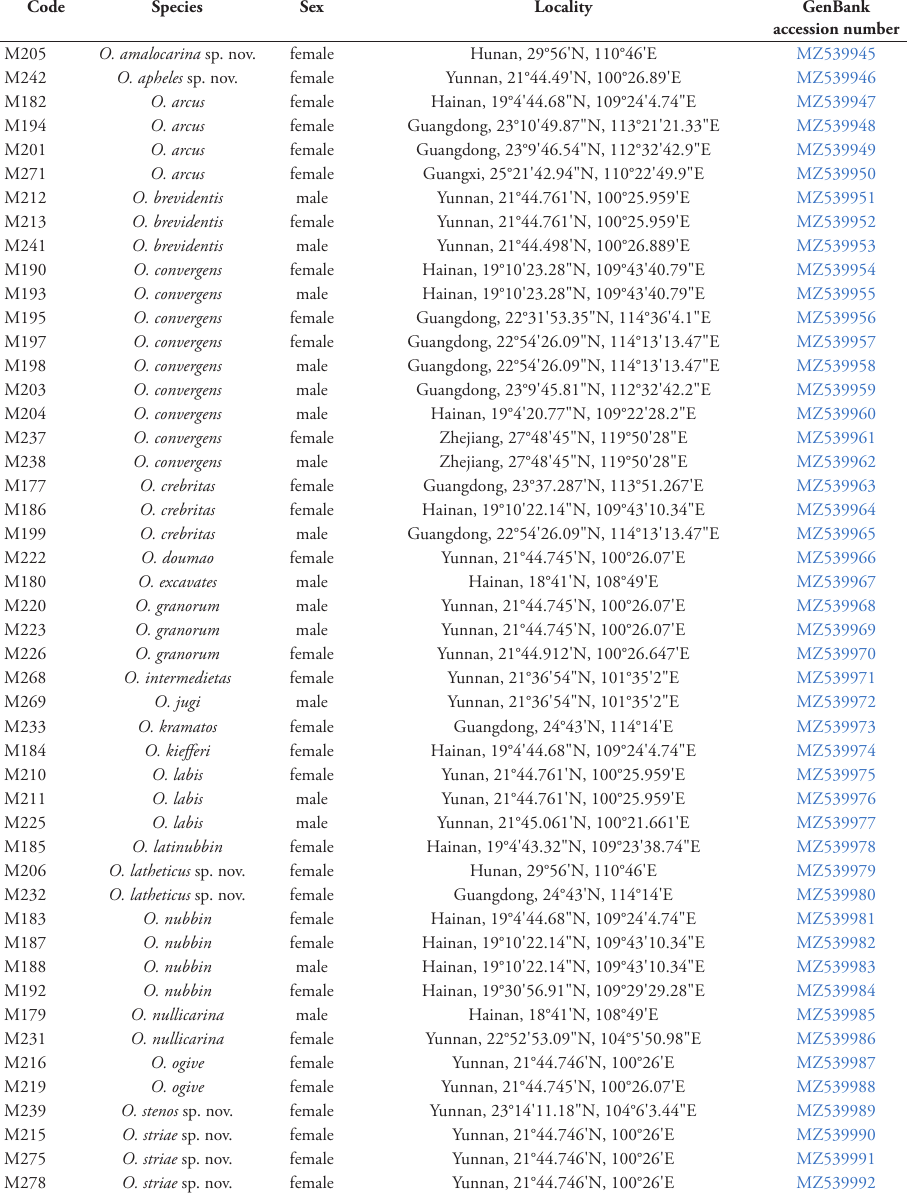
Table 1. List of sequenced taxa and accession